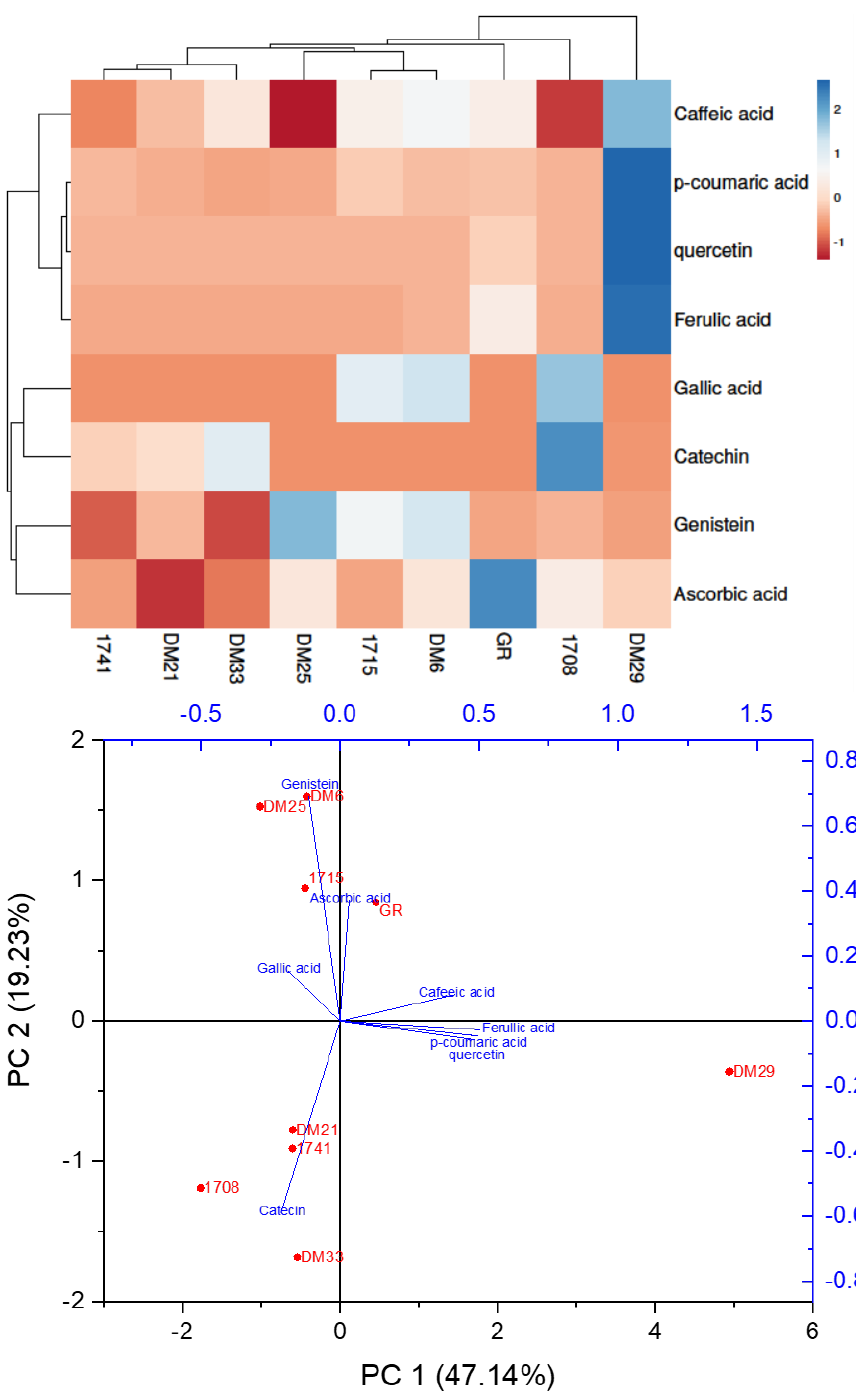
Figure 5. Different colored rice varieties have different phenolic phytochemicals levels. ( A ) The heat map depicts varying levels of phenolics, with blue indicating a higher level and red indicating a lower level of phenolics. ( B ) By comparing PC 1 and PC2, the principal component analysis (PCA) of rice varieties was